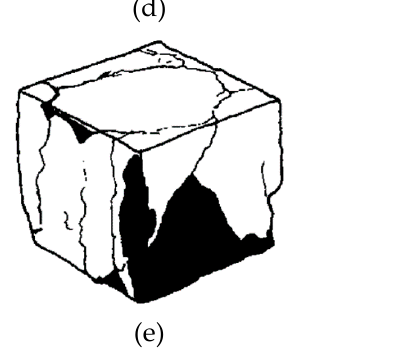
Figure 14. Fracture pattern (aggregate in blue and cement matrix in gray) and fracture surfaces (ITZ in blue and cement matrix interfaces in gray) in different states during the loading process in Figure 13: ( a ) state A, ( b ) state B, ( c ) state C, ( d ) state D and ( e ) the final fracture pattern in experiments [46].